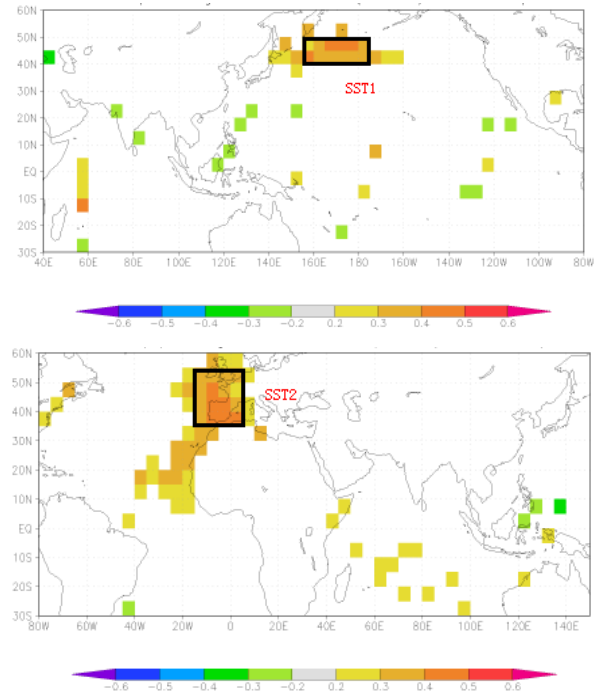
Figure 3: SST regions (SST1 and SST2) that influence the rainfall and streamflow Fig. 3. SST regions (SST1 and SST2) that influence the rainfall and in the Huai River Basin. SST regions that have significant correlation at 95% confidence interval (>0.25 or < -0.25) are considered as predictors for the streamflow in the Huai River basin. SST regions that have signif- Hierarchical Bayesian Model. icant correlation at 95% confidence interval ( > 0.25 or < − 0.25) are considered as predictors for the hierarchical Bayesian